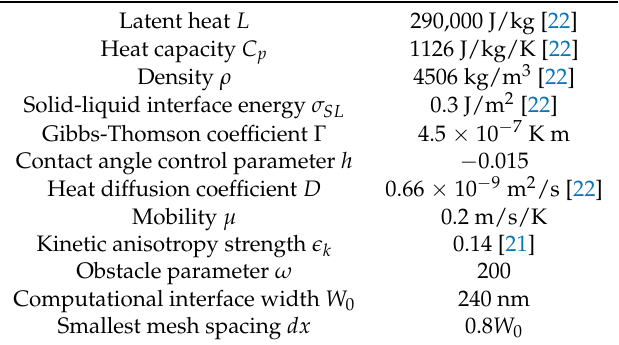
Table 2. Thermal phase field model parameters for Ti-6-4